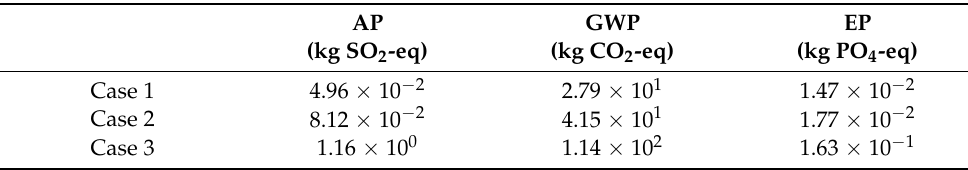
Table 2. Total environmental impact of three scenario